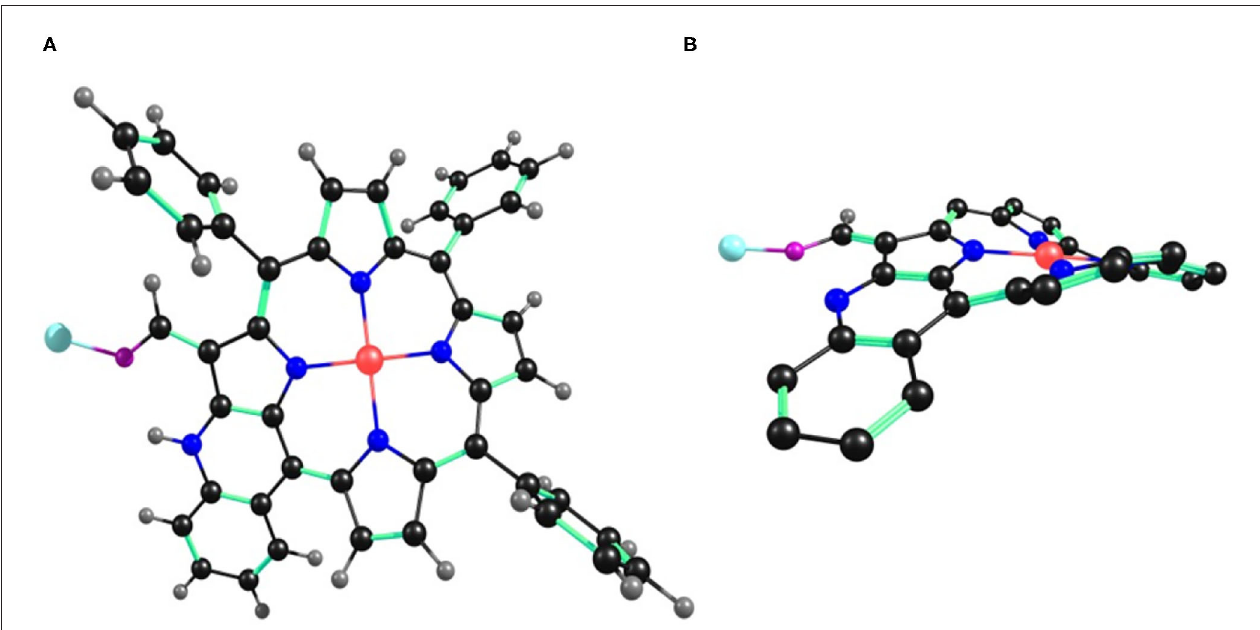
FIGURE 10 | B3LYP/LANL2DZ optimized geometry of 2 • Cu + 2 showing (A) top view and (B) side view. In the side view, all the hydrogen atoms (except –CHO) and phenyl substituents (except cyclized phenyl) have been removed for clarity.